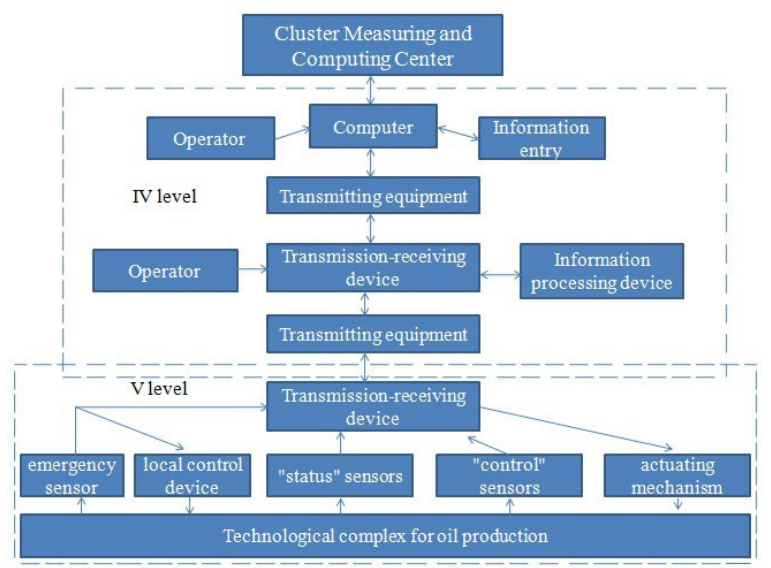
Figure 3. Scheme of information flows in the oil and gas production department in terms of technological complexes for oil production.